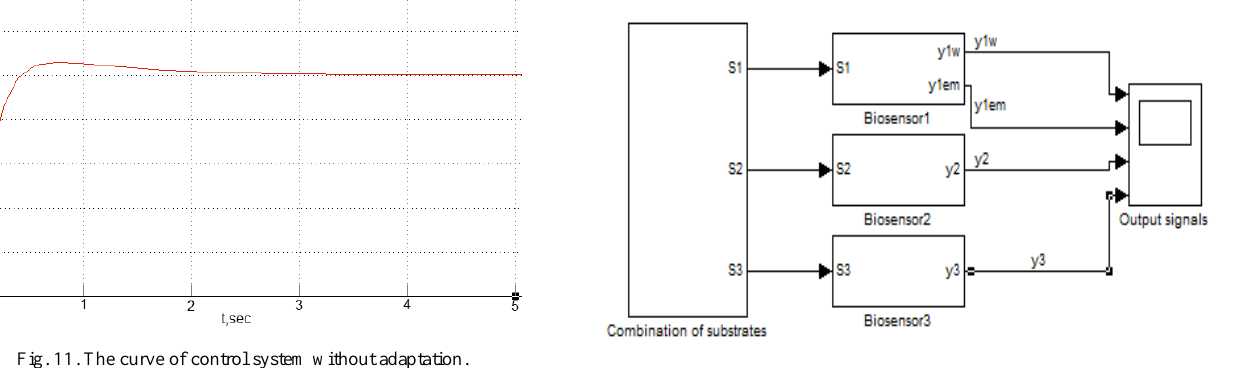
Fig. 14. Computer simulation interface for a biosensor system. Concentration can be measured in different units, here it is in mol/L. So, it is assumed, that the warning concentration of S 1 is S 1 w = 5 (mol/L), the emergency concentration of S 1 is S 1 em = 10 (mol/L), the emergency concentration of S 2 is S 2 em = 10 (mol/L), the emergency concentration of S 3 is S 3 em = 10 (mol/L). The values of output signals that correspond to different concentration of S 1 , S 2 and S 3 are shown in Table I.